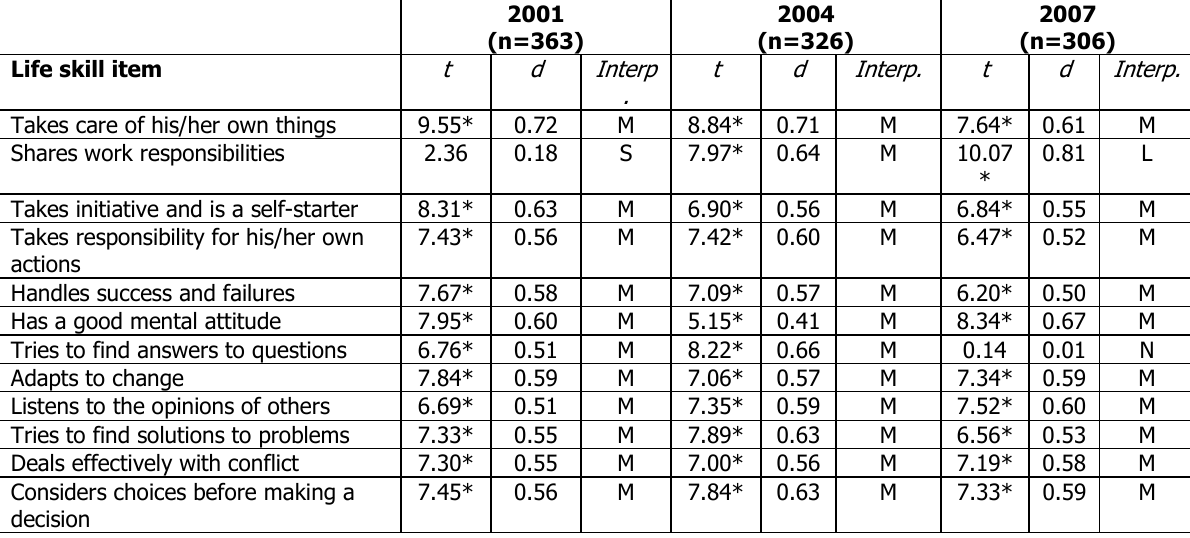
Statistical and Practical Significance of Camper Life Skill Behaviors by